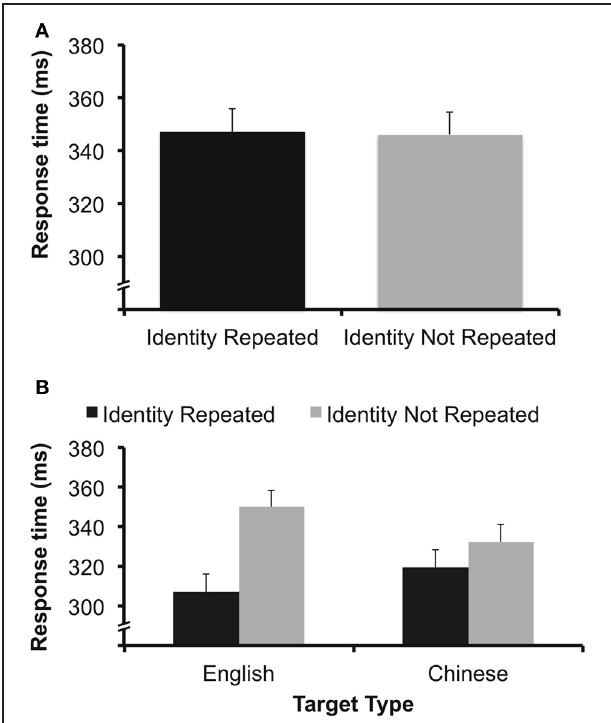
FIGURE 6 | (A) Data from Experiment 3A. There was no effect of target identity repetition. Error bars represent 95% confidence interval (e.g., Loftus and Masson, 1994). (B) Data from Experiment 3B. There was a benefit to repeating target identity for both English letters and Chinese letters. Error bars calculated from a within-subjects interaction error term (e.g., Loftus and Masson, 1994).